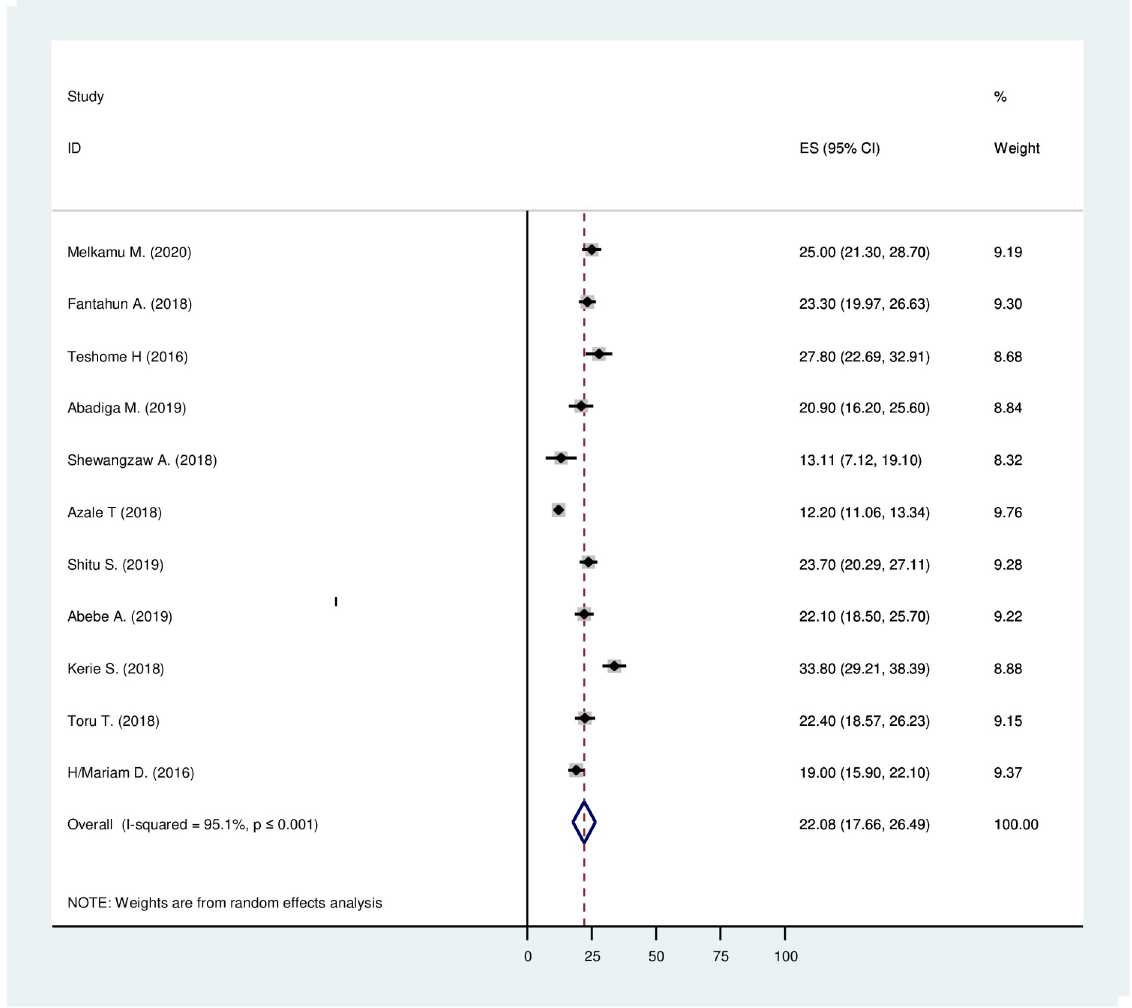
Fig 4. The estimated pooled prevalence of post-partum depression among mothers after giving birth in Ethiopia, 2020.